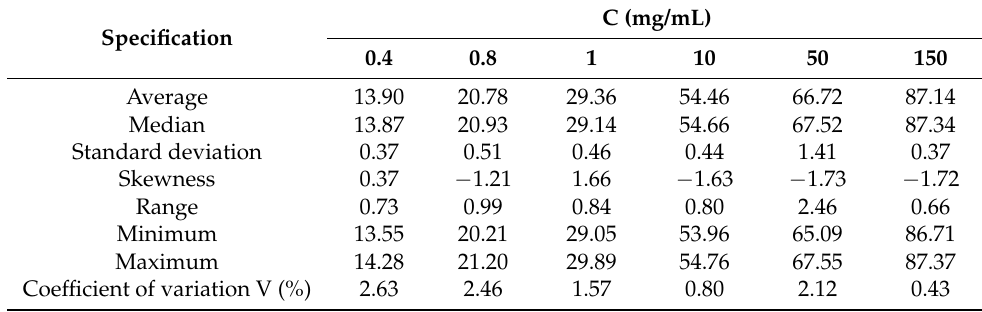
Table 5. Descriptive statistics of the DPPH radical scavenging effect of Thymus algeriensis leaf essential oil.